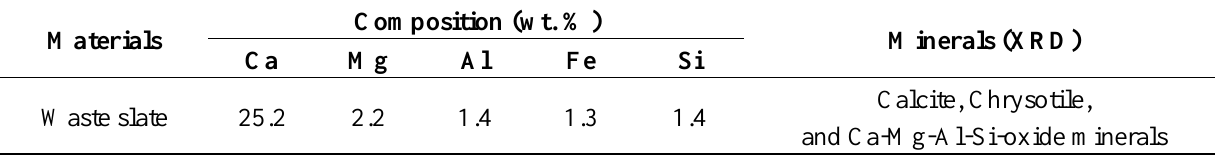
Table 1. Chemical and mineralogical characteristics of as-received waste slate sample.